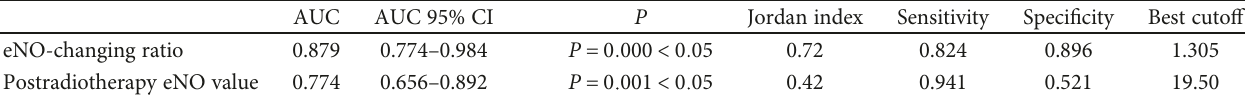
Table 2: Evaluation of the ability of NO in predicting